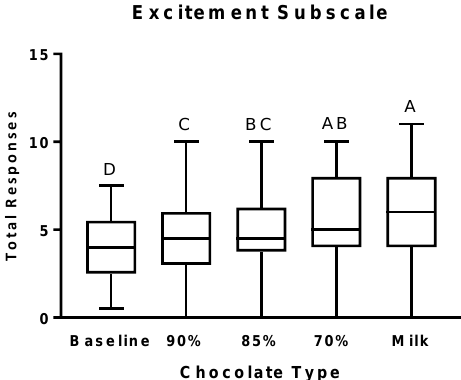
Figure 4. Excitement (E) subscale scores after the consumption of chocolates differing in cocoa, sugar, and fat content. Self-reported scores on the E subscale are presented as box and whiskers plots with the line representing the median, the box representing the 25th to 75th percentiles, and the whiskers representing the minimum to maximum values. Least-squares means are Baseline: 3.51 ± 0.47 (SE), 95% CI [2.56, 4.46]; 90% cocoa: 4.57 ± 0.44 (SE), 95% CI [3.68, 5.45]; 85% cocoa: 4.80 ± 0.44 (SE), 95% CI [3.92, 5.68]; 70% cocoa: 5.53 ± 0.44 (SE), 95% CI [4.65, 6.42]; Milk: 6.27 ± 0.44 (SE), 95% CI [5.38, 7.15]. Levels not connected by the same letter are significantly